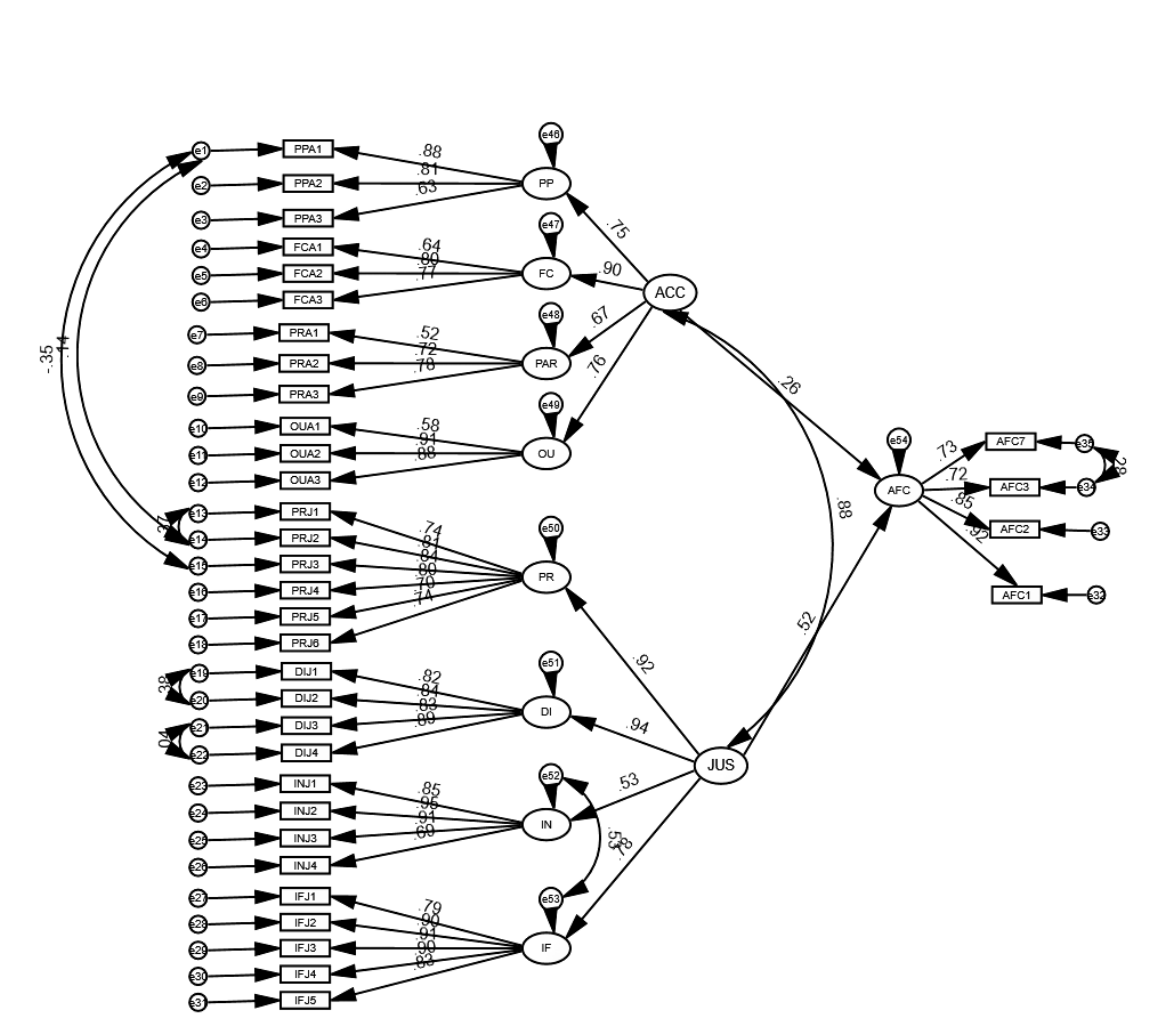
Figure 2. Structural model 2